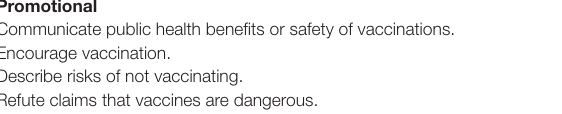
TABLE 1 | Vaccine stance classification. Promotional Communicate public health benefits or safety of vaccinations. Encourage vaccination. Describe risks of not vaccinating. Refute claims that vaccines are